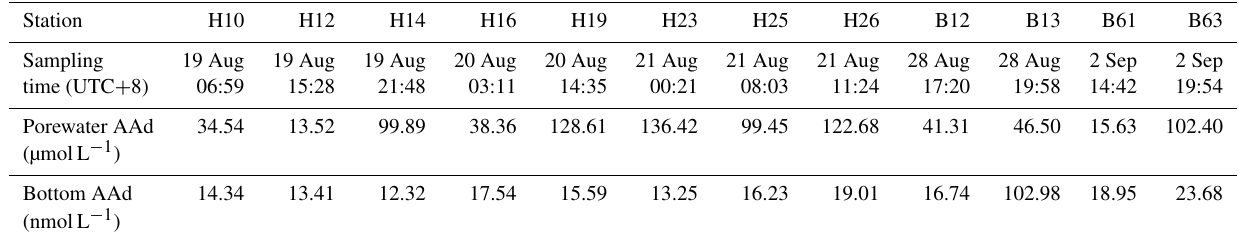
trast to the results obtained in summer. The enzymatic